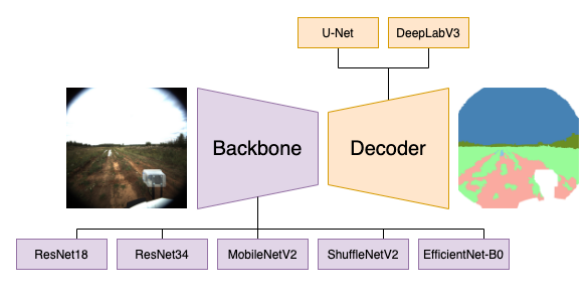
Figure 10. Proposed backbones and decoders